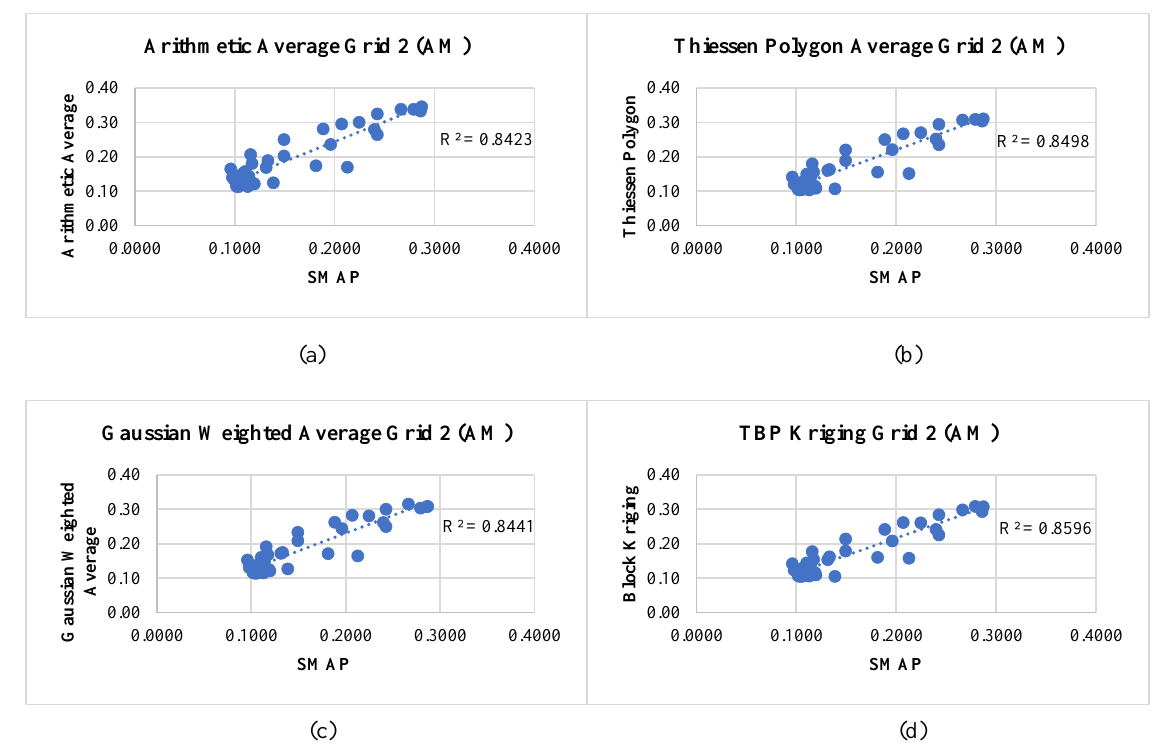
Figure 8. Grid 2 — spatial autocorrelation detected: correlation plot between the morning SMAP data and the four upscaling algorithms. ( a ) arithmetic average; ( b ) Thiessen polygon method; ( c ) Gaussian-weighted average; ( d ) TBP kriging.